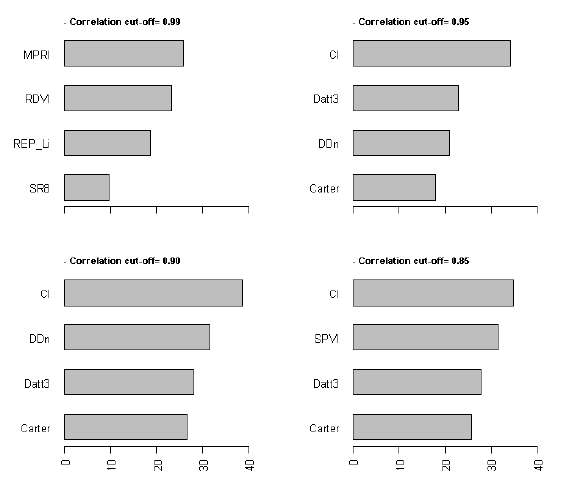
Figure 6 - Variable importance for tolerable dataset Tolerable models for all five cut-off values are validated ( as per Figure 7) and have present similar performance as in training- testing stage. Results are summarized on Table 2: On interest of avoiding similar figures, only the selection process of tolerable/optimal model for a cut-off of |0.99| is displayed.